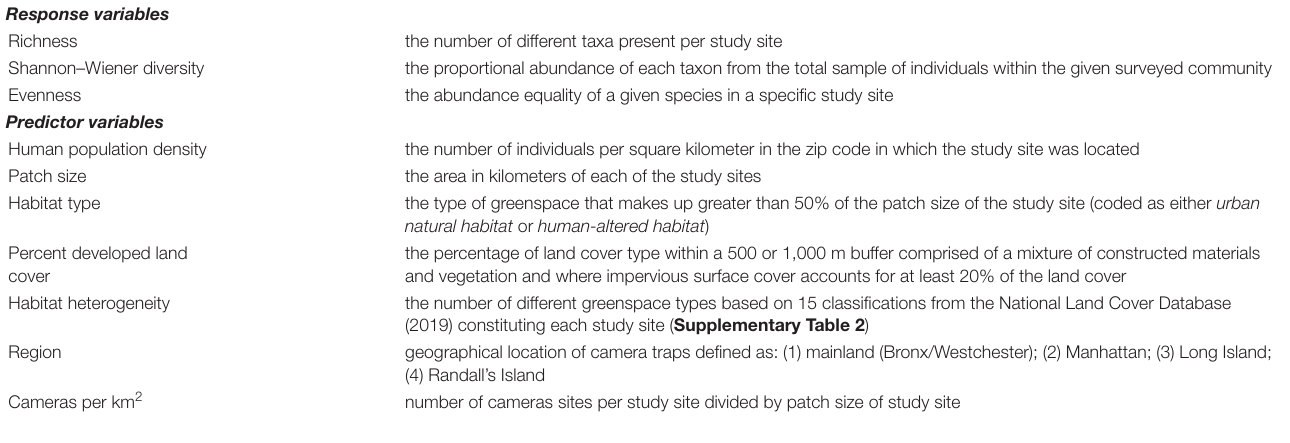
TABLE 2 | Response and predictor variables for mammalian diversity among 31 greenspaces in the New York metropolitan